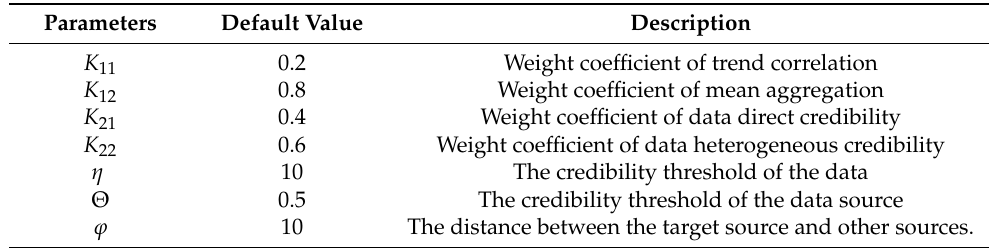
Table 4. Experimental parameter